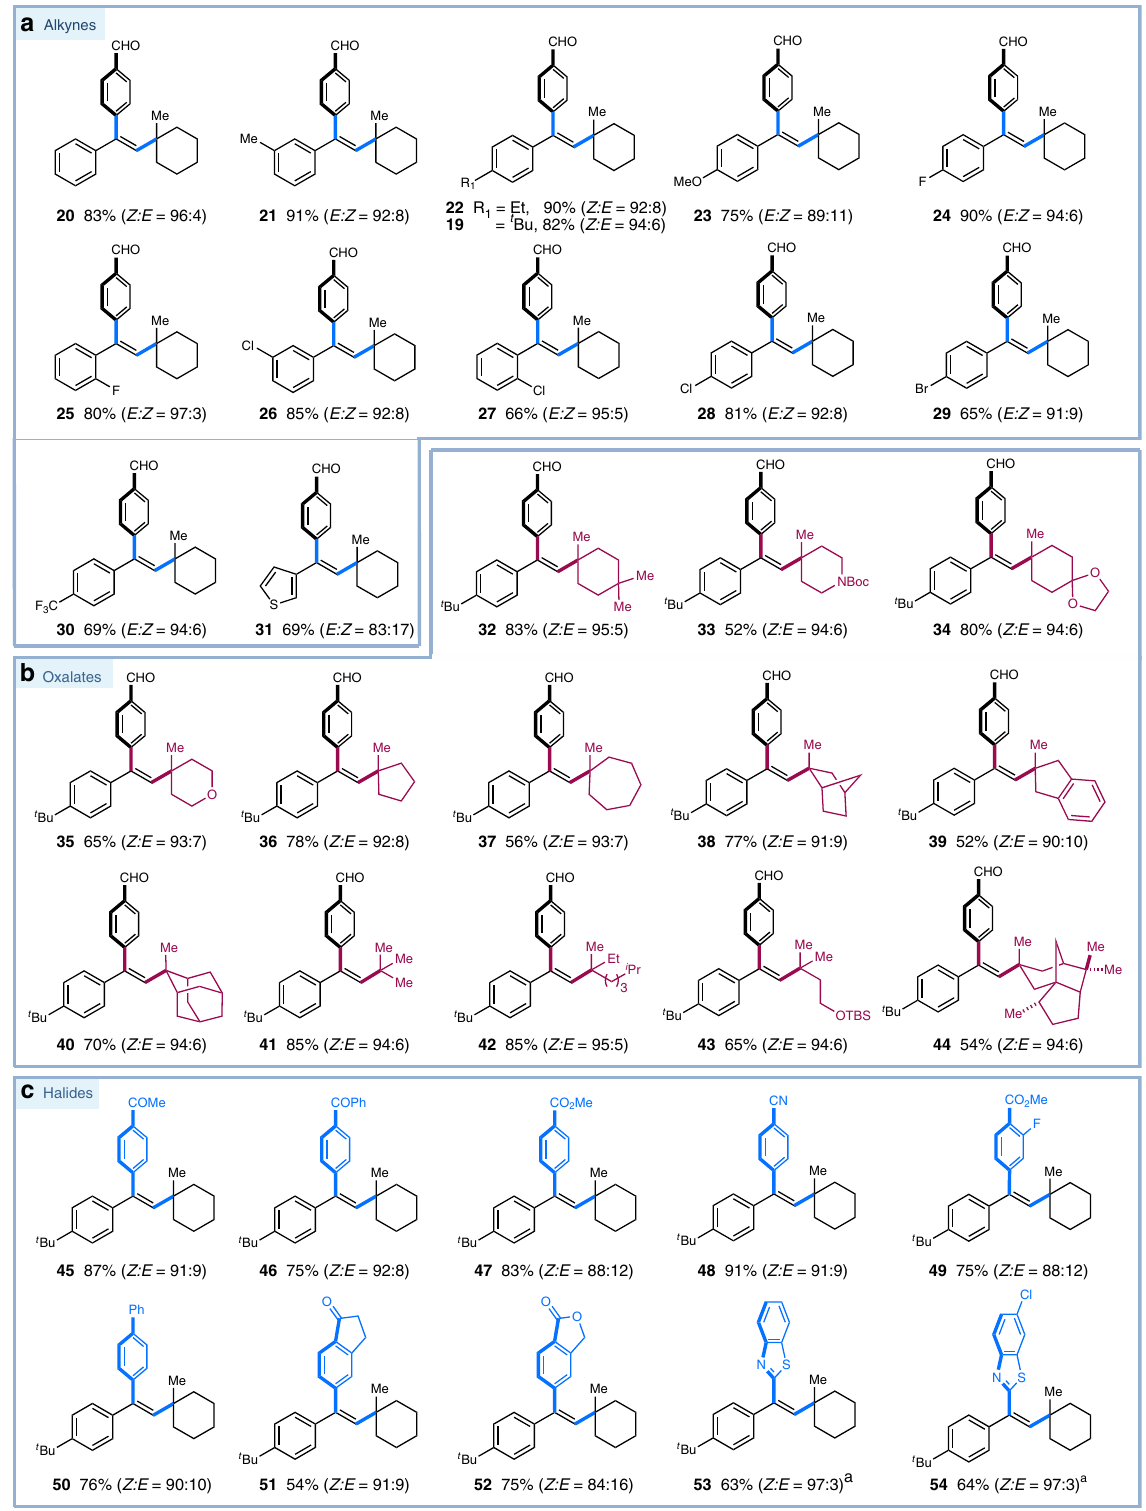
Fig. 3 Substrate scope. a Scope of alkynes. b Scope of cesium oxalates. c Scope of aryl halides. Reaction conditions: Ir- 1 (3 mol%), NiCl 2 (cid:129) glyme (20 mol%), dtbbpy (20 mol%), alkyne (0.1 mmol), oxalate (1.5 equiv.), bromide (2.0 equiv.), DMSO [0.05 M], 90 W blue LED, 36 °C, 18 h. All cited yields are isolated yields. The ratios of the two isomers were determined by 1 H NMR analysis of the crude reaction mixtures. a Heteroaryl chloride was employed. dtbbpy = 4,4 ′ -di- tert -butyl-2,2 ′